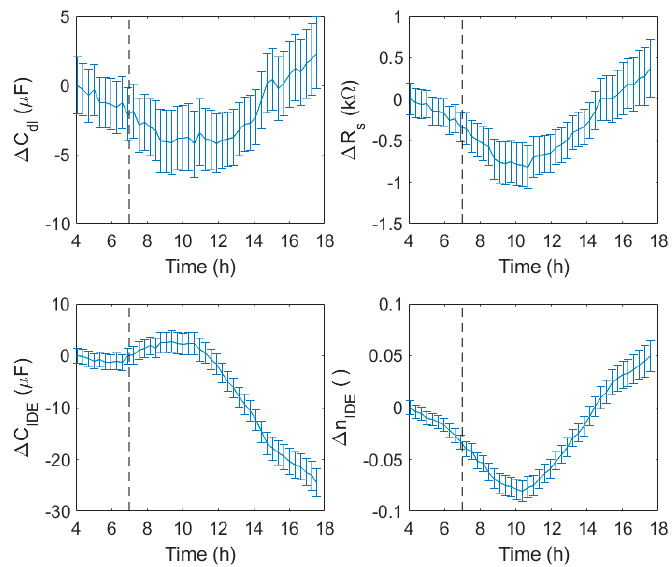
Figure 13. Variations of the equivalent electrical model parameters values obtained on the wells with the phage with respect to the values of the wells with the phosphate buffered saline (PBS). The bars represent the fitting error.